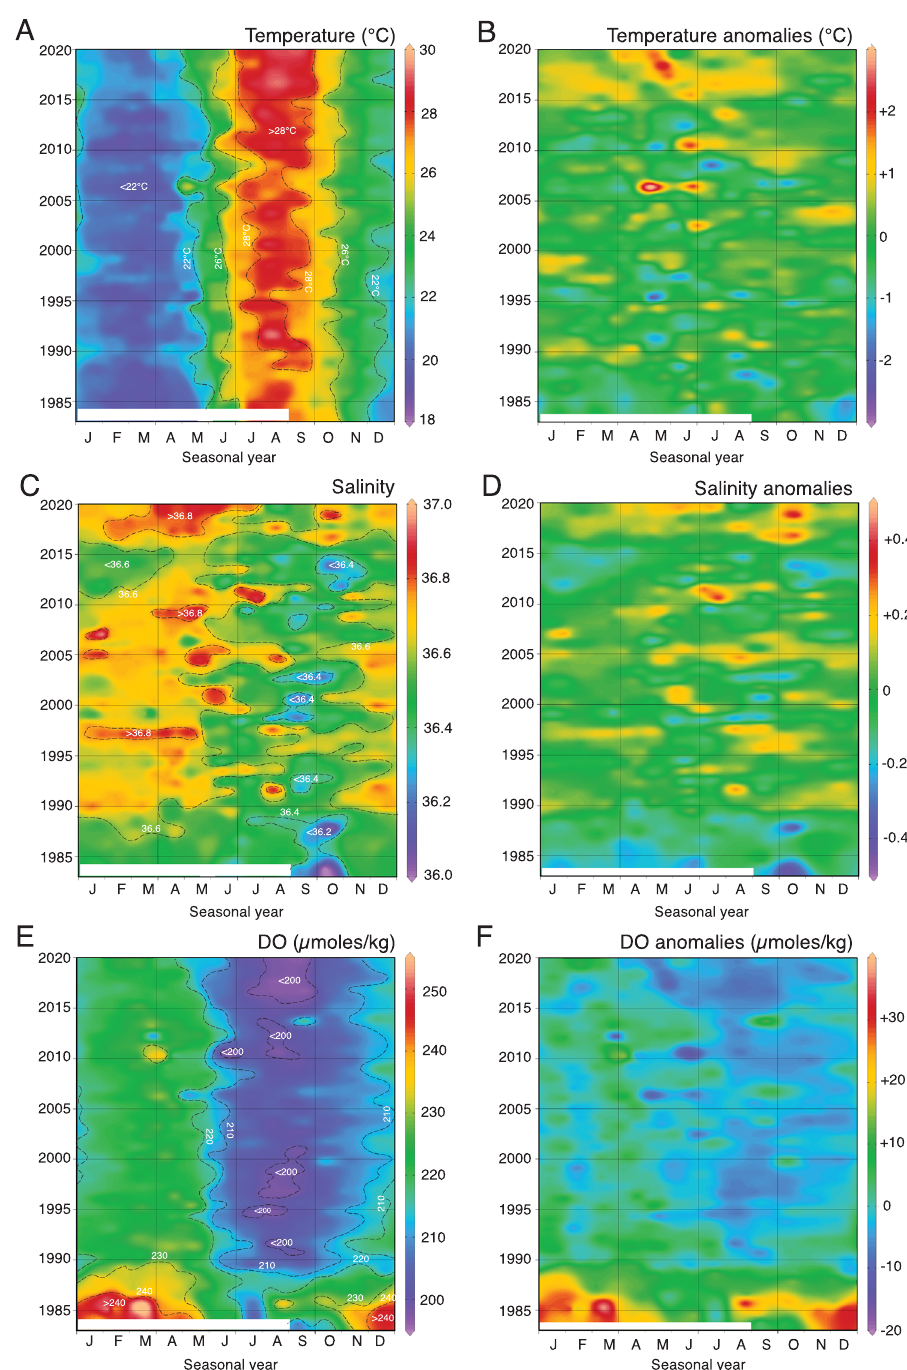
Fig. 3 Physical properties at BATS (1988 – present) with earlier data (1983 – 1988) from Hydrostation S. a Surface temperature (°C). b Surface temperature anomalies (°C). c Surface salinity. d Surface salinity anomalies. e Surface dissolved oxygen DO ( µ moles kg − 1 ). f Surface dissolved oxygen DO anomalies ( µ moles kg − 1 ). Please note that the occasional high and low summertime DO events observed in the 2000s occur both at hydrostation S and BATS indicating that these features are “ real ” surface phenomena. Dashed lines for contours are